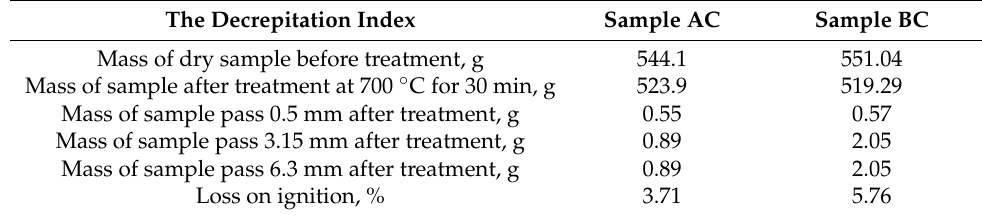
Table 3. The decrepitation index of samples AC and BC.